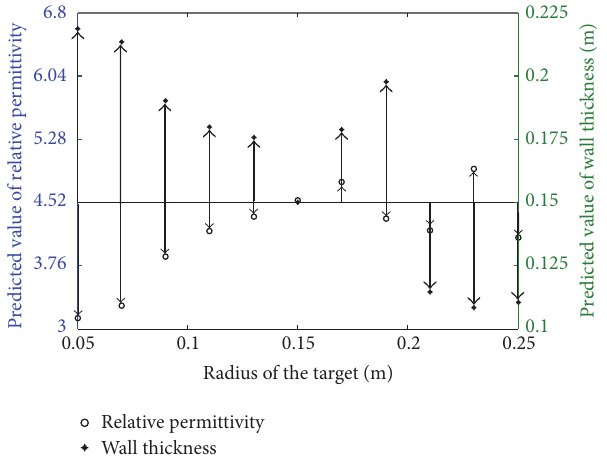
Figure 6: The estimated values of the wall parameters versus radius of the target.